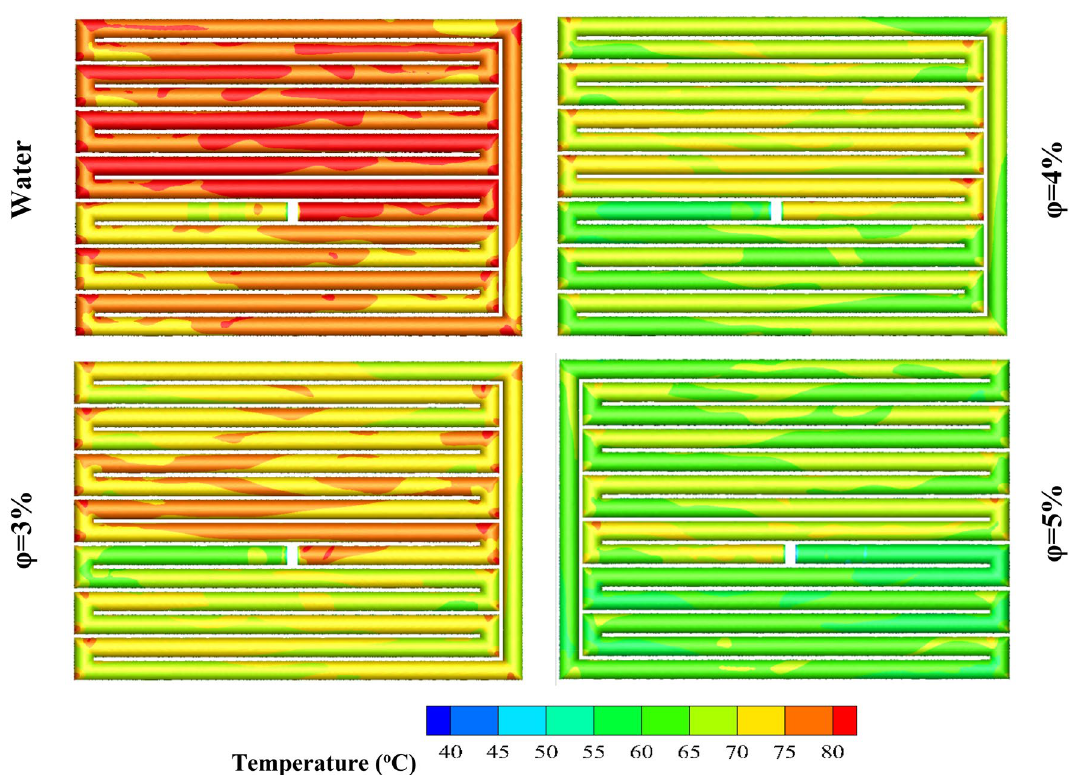
Fig. 22 Temperature distribution on WCP hot-side